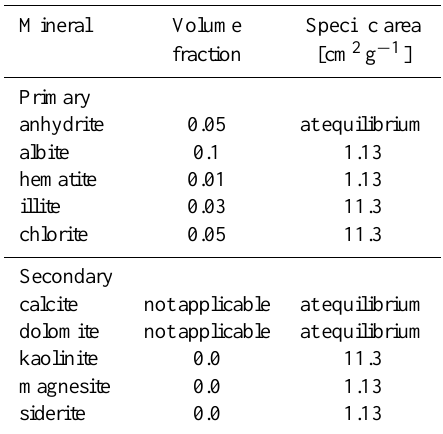
Table 2. Minerals included in the model.